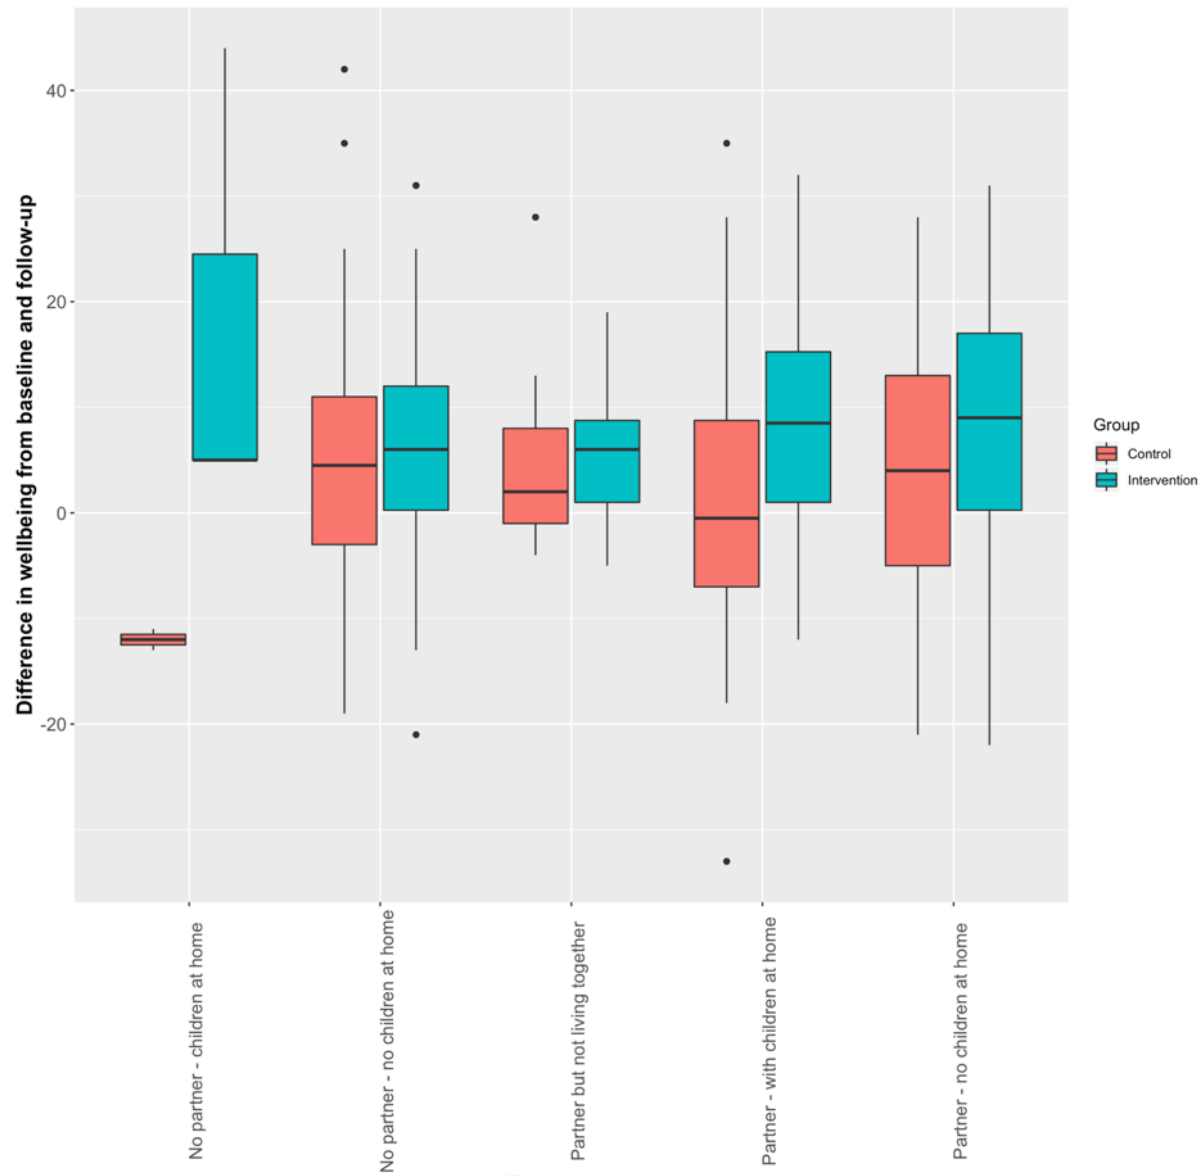
Figure 2. Interaction between group allocation and marital